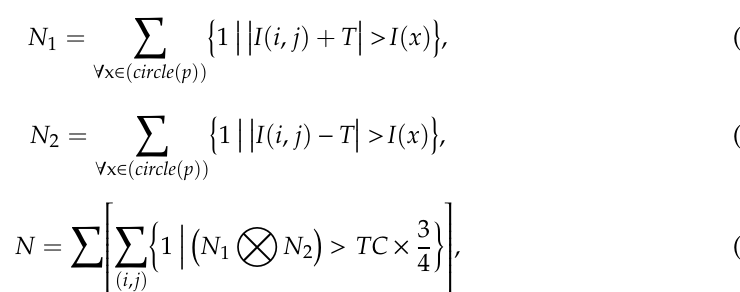
Figure 2. Matching rate under various scale ratio values.